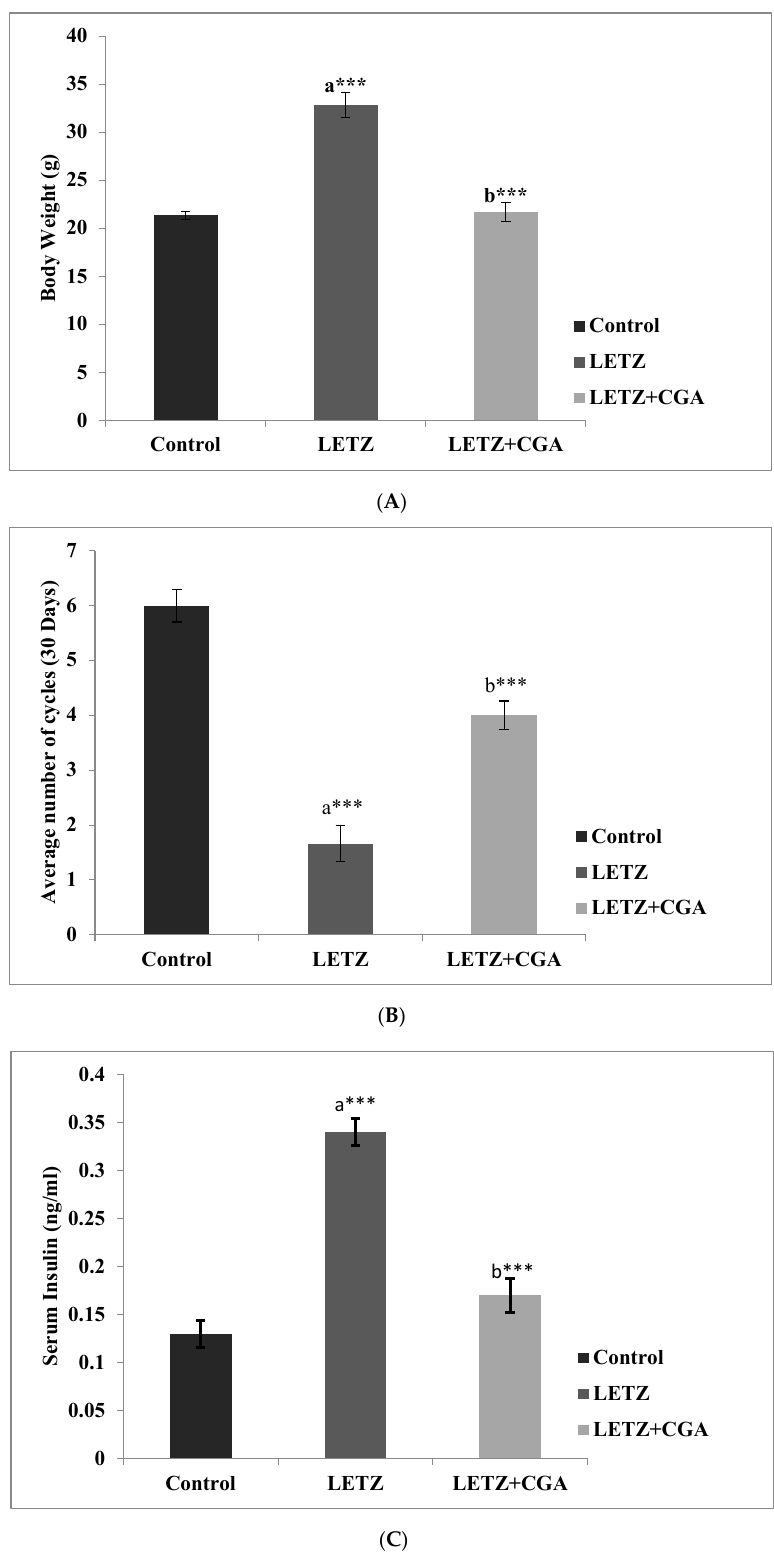
Figure 1. ( A ) Impact of CGA on ovary body mass. PCOS: letrozole (6 mg/kg); control: normal saline; PCOS with CGA: LETZ at 6 mg/kg and CGA at 50 mg/kg; a = PCOS versus control; b = LETZ versus LETZ with CGA. With n = 6 per group, all values are expressed as means with standard errors. *** p < 0.001; g = grams; CGA = chlorogenic acid; LETZ = letrozole. ( B ) Effect of CGA on estrous cycle in mice with PCOS. Control: normal saline; PCOS: letrozole (6 mg/kg); PCOS with CGA: LETZ at 6 mg/kg and CGA at 50 mg/kg; a = PCOS versus control; b = LETZ versus LETZ with CGA. With n = 6 per group, all values are expressed as means with standard errors. *** p < 0.001; CGA = chlorogenic acid. (C) Effect of CGA on serum insulin levels in mice with PCOS. Control: normal saline; PCOS: letrozole (6 mg/kg); PCOS with CGA: LETZ at 6 mg/kg and CGA at 50 mg/kg; a = LETZ versus control; b = LETZ versus LETZ with CGA. With n = 6 per group, all values are expressed as means with standard errors. *** p < 0.001; CGA = chlorogenic acid. Table 2. Impact of CGA on fasting glucose and lipid profiles in PCOS mice. Groups